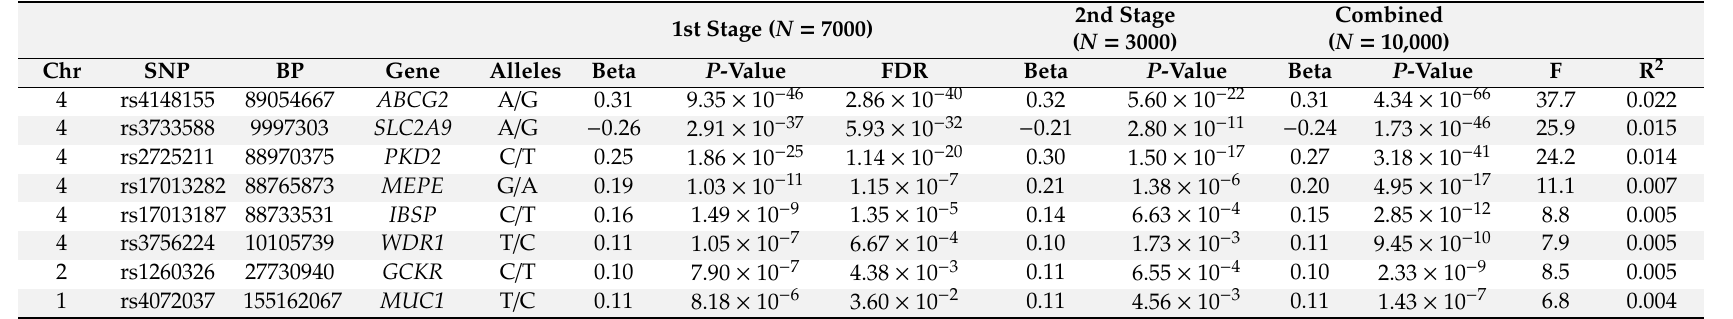
Table 1. Single nucleotide polymorphisms (SNPs) selected from two-stage genome-wide association study